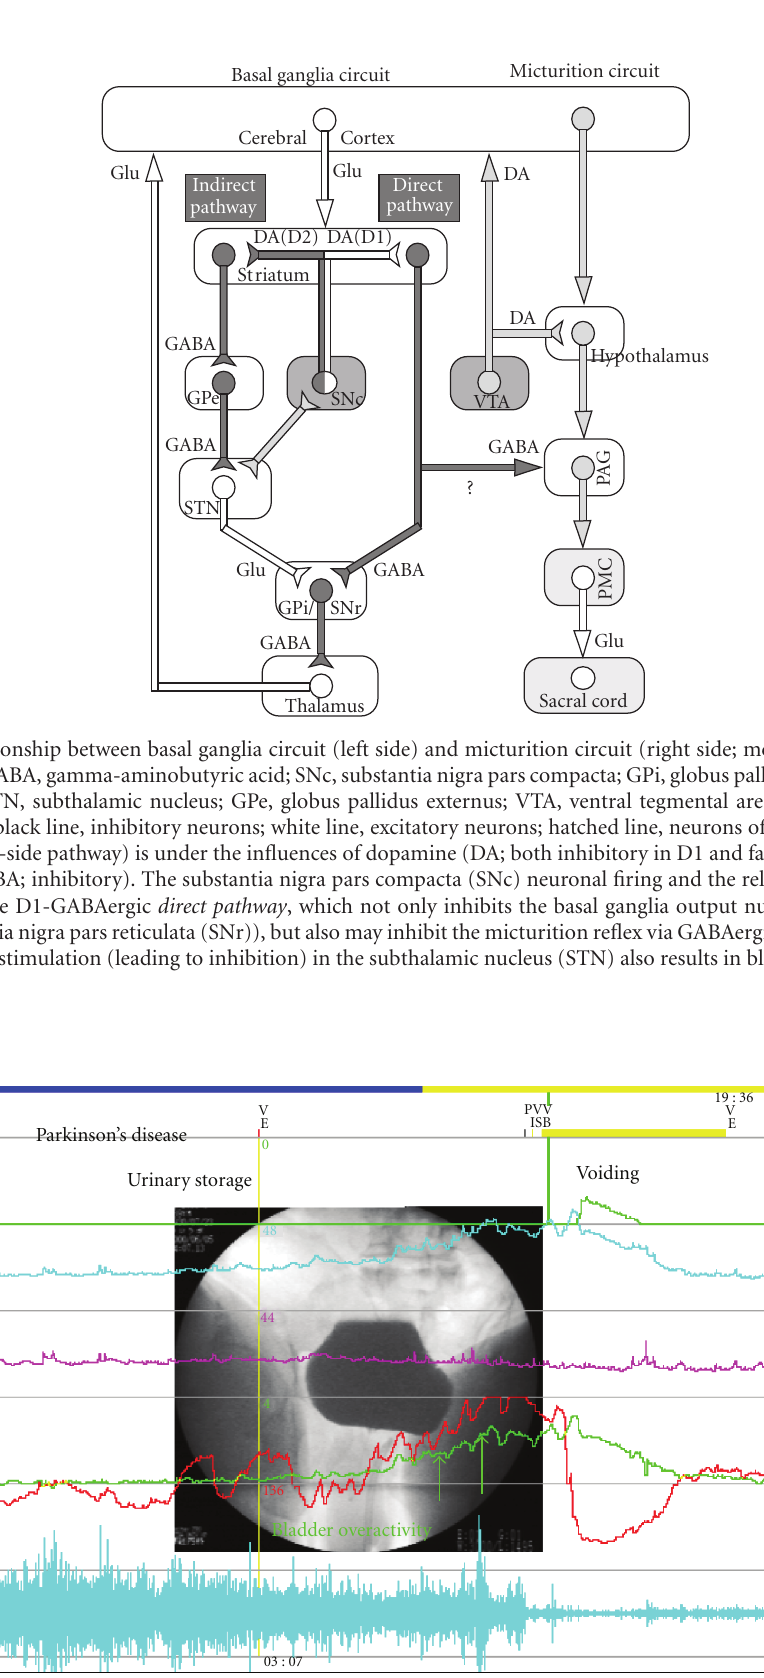
Figure 3: Detrusor (bladder) overactivity by urodynamic